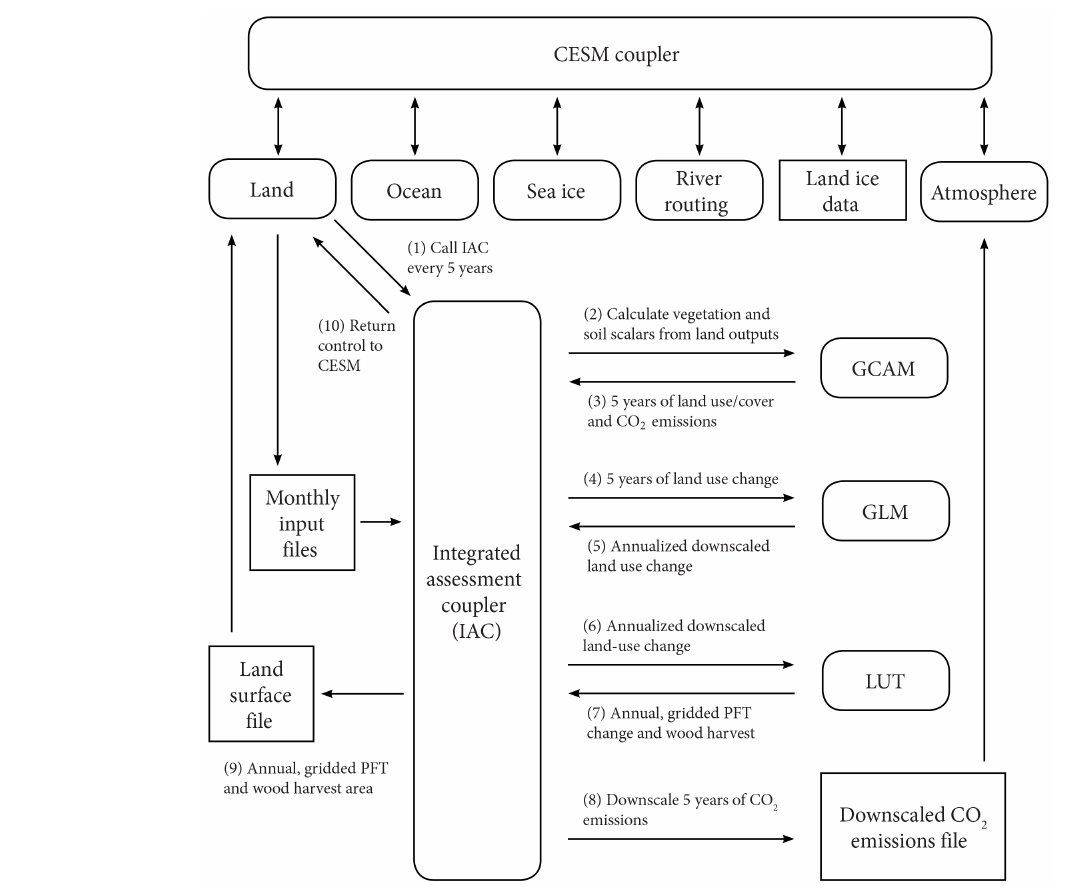
Figure 6. Structure of iESM and feedback between integrated model components. An integrated assessment coupler facilitates all inter- actions between the Global Change Assessment Model (GCAM), the Global Land-Use Model (GLM), and the Community Earth System Model (CESM). The coupler is activated by the CESM land model every 5 years to calculate the average carbon and productivity scalars for the past 5 years and pass them to GCAM, then pass GCAM outputs to the atmosphere component of CESM via a downscaling algorithm and to GLM, and then pass GLM outputs to the land component via a land-use translator (LUT). The non-CO 2 emissions are provided to CESM as an input data